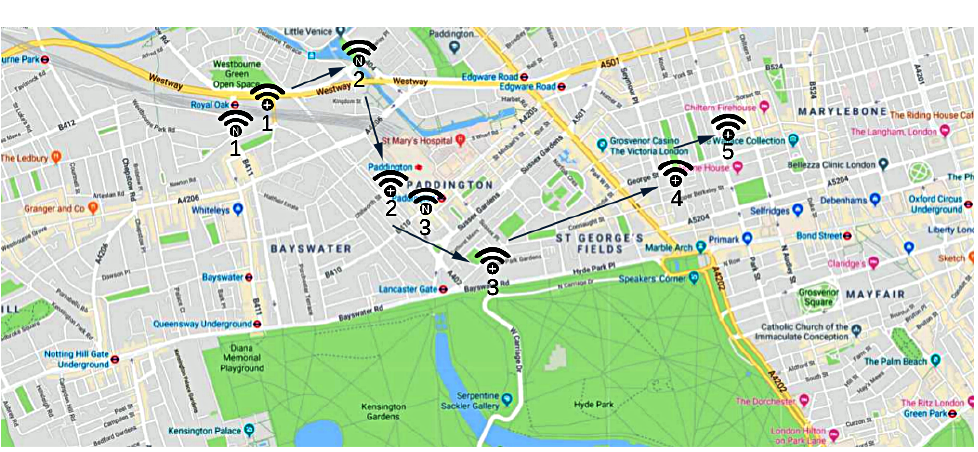
Figure 9. IoE interpolate